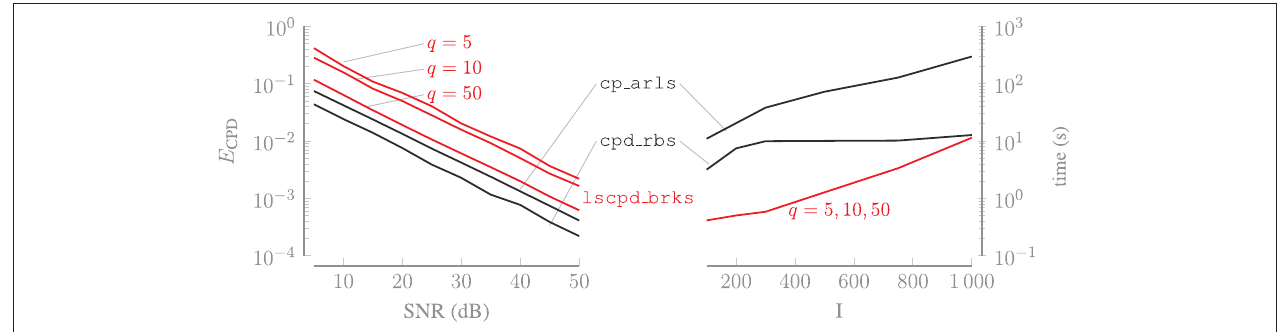
FIGURE 3 | Increasing the oversampling factor q of lscpd_brks , for which the value is shown in the figure, greatly improves its accuracy while having a negligible effect on the computation time. Algorithm lscpd_brks is faster than cp_arls and cp_rbs , for a range of tensor dimensions that are relevant for applications, with a limited loss of